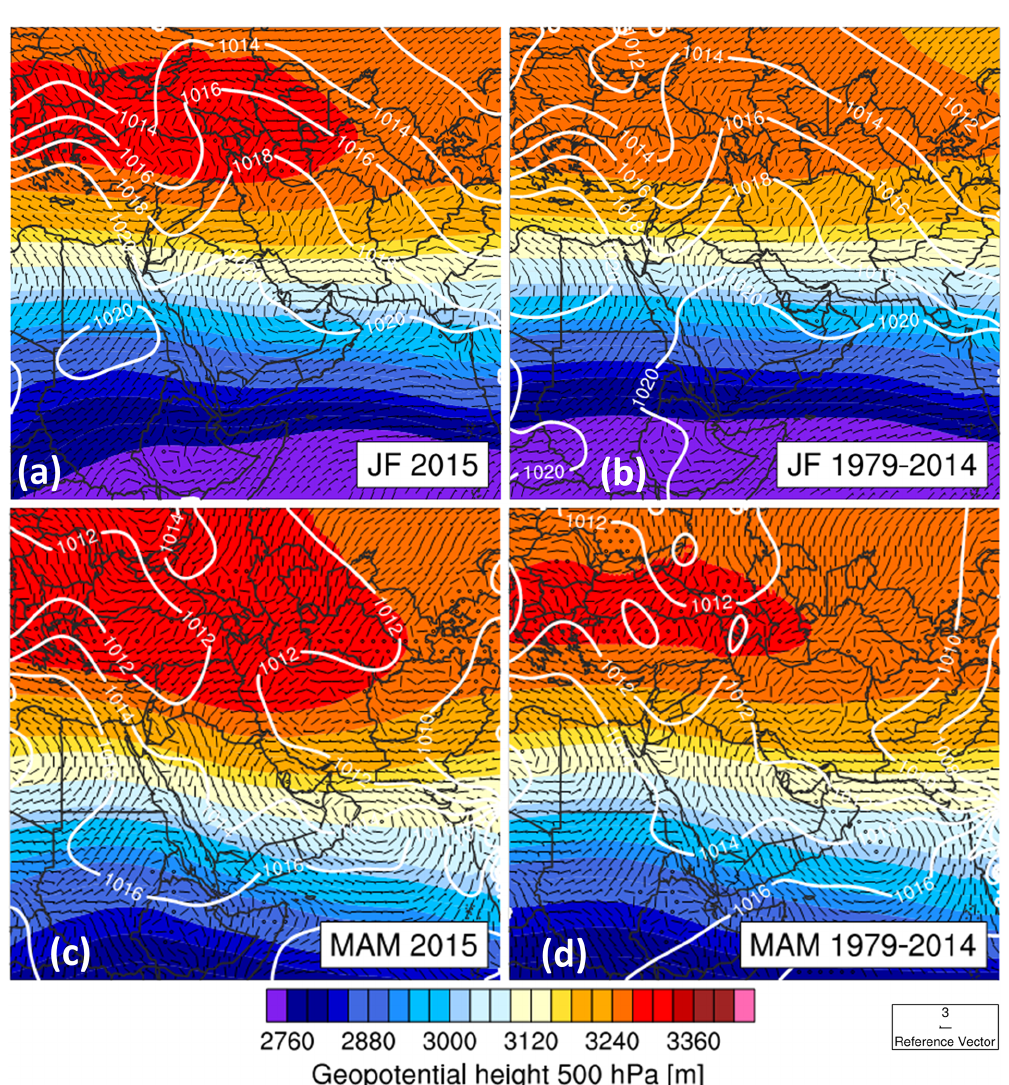
Figure 2. Comparison of the 2015 (a) winter (January–February, JF) and (c) spring (March–May, MAM) large-scale fields at 08:00UTC. Panels (b) and (d) are an equivalent 36-year climatology between 1979 and 2014. Variables shown are geopotential height at 500hPa (m; shading), wind velocity at 850hPa (ms − 1 ; see reference vector at bottom right), and mean sea level pressure (hPa; white contours). Data are taken from the ECMWF ERA5 reanalysis